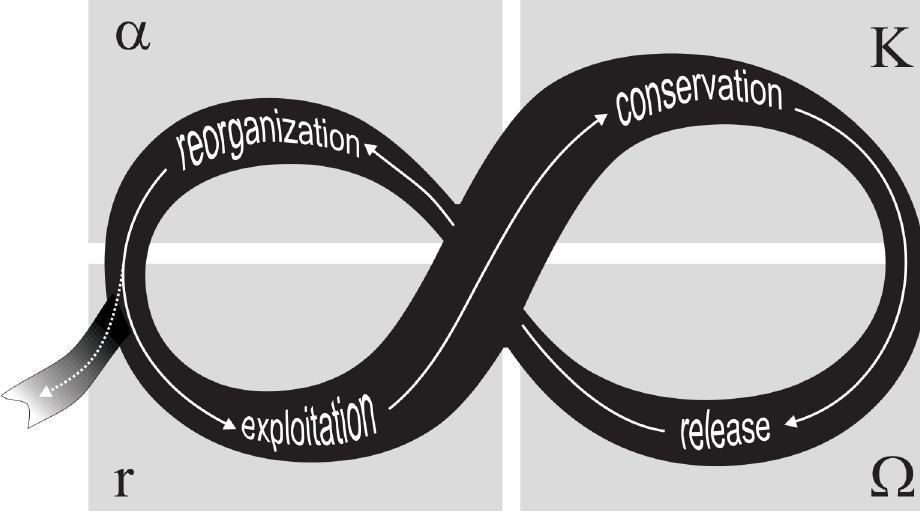
Fig 1. Schematic description of the adaptive cycle. It shows transitioning between four phases ( α , r, K, Ω ) within a specific regime (full white arrows) and the potential to change to a new regime in the reorganisation phase (dotted white arrow). Modified from Gunderson and Holling